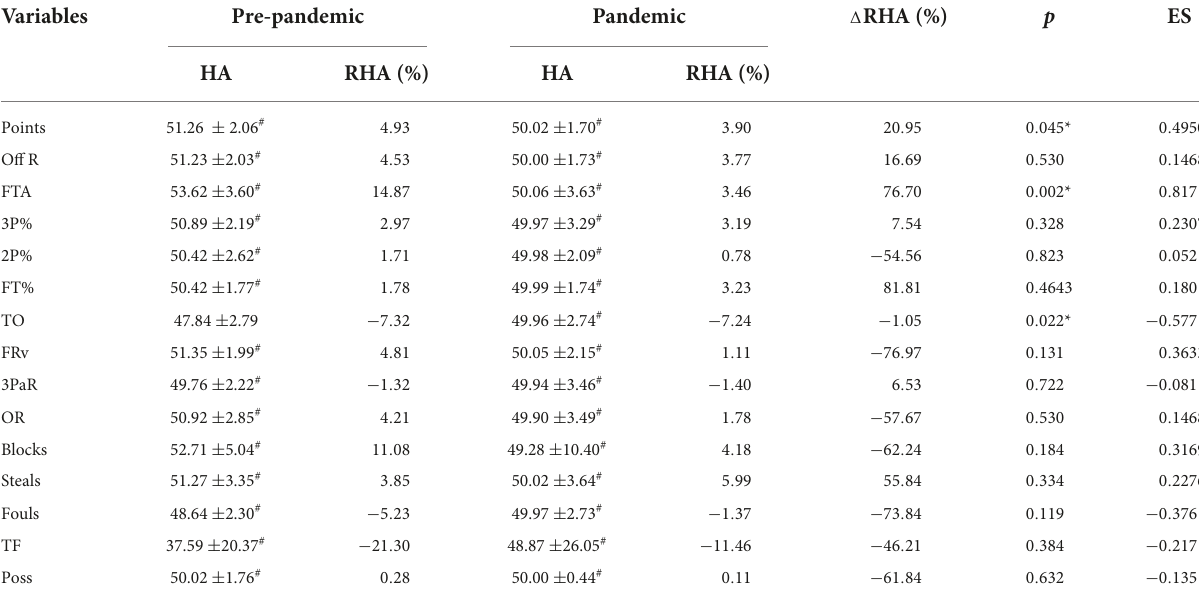
Thevaluesareexpressedasmeanandstandarddeviationbothinpre-pandemicandpandemicseasons. Abbreviation:OffR,offensiverate;FTA,freethrowattempts;3P%,three-pointpercentage;2P%,two-pointpercentage;FT%,freethrowpercentage;TO,turnovers;FRv,foulreceivedrate; 3PaR,three-pointattemptrate;OR,offensiverebounds;TF,technicalfouls;Poss,possessions; (cid:49) ,variation; p, betweengroup-subjecteffect. # IndicatesapplicableHAdifferencesbetweenhomeandawayteams.